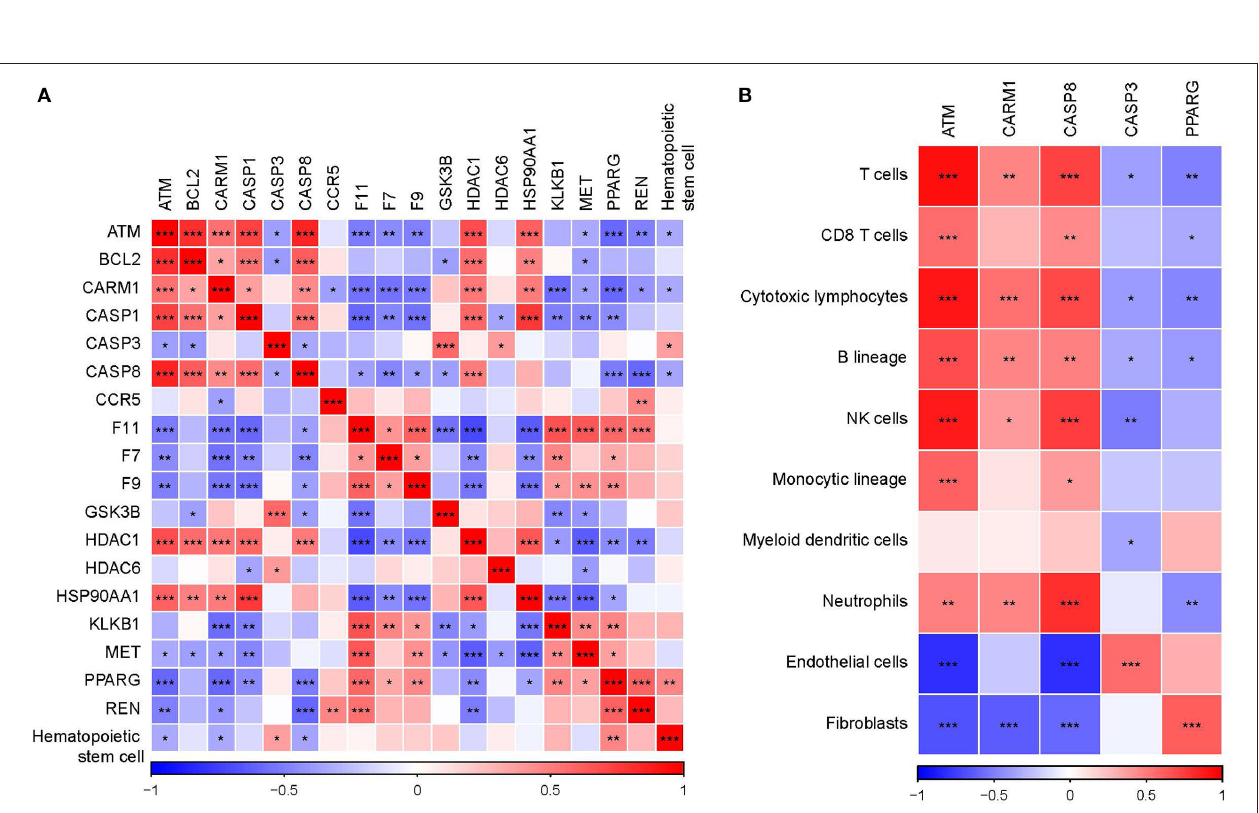
FIGURE 6 | Identification of key genes in hub clusters. (A) Correlation analysis between key genes and hematopoietic stem cell. (B) Correlation analysis between key genes and immune score calculated by MCPcounter. * p < 0.05, ** p < 0.01, *** p < 0.001.